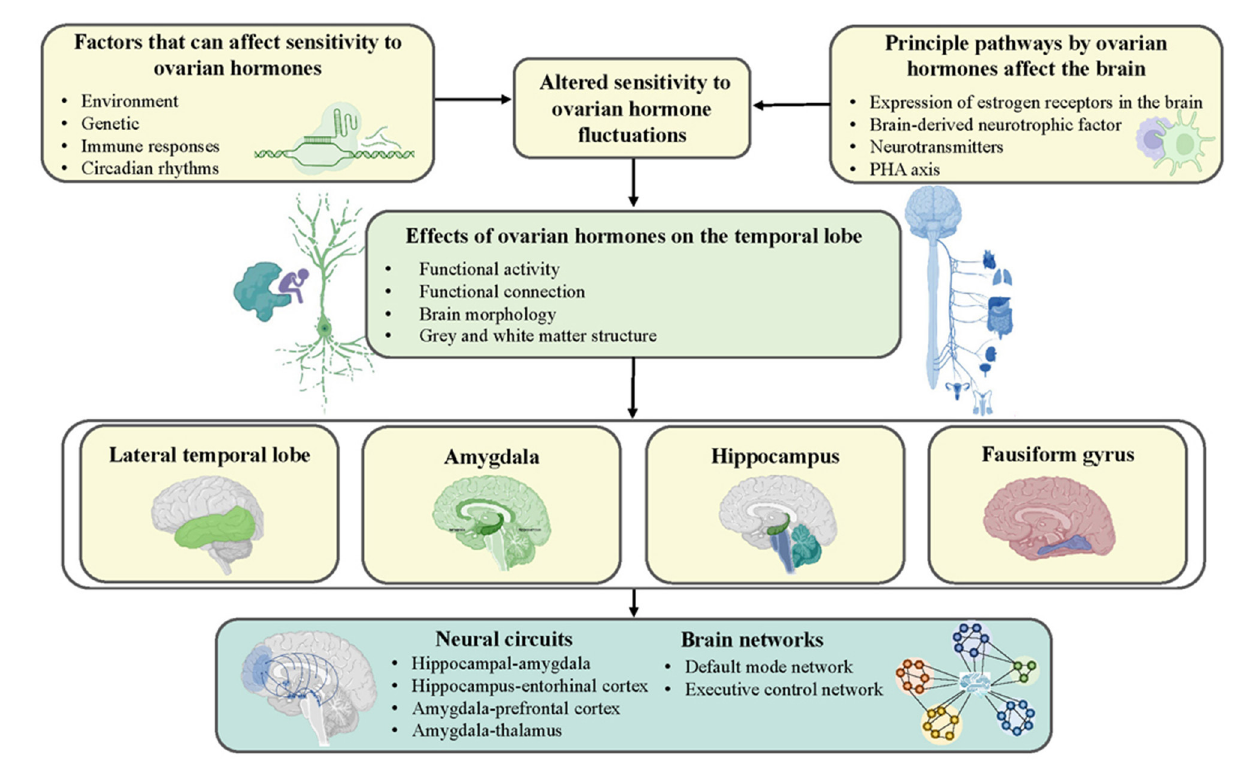
FIGURE 1 | Schematic representation of possible mechanisms by which ovarian hormones contribute to the development of PMS and PMDD. Genetics, environment, immune response, and circadian rhythms increase women’s sensitivity to ovarian hormones and shape the temporal lobe by affecting neurotransmitters and hormonal